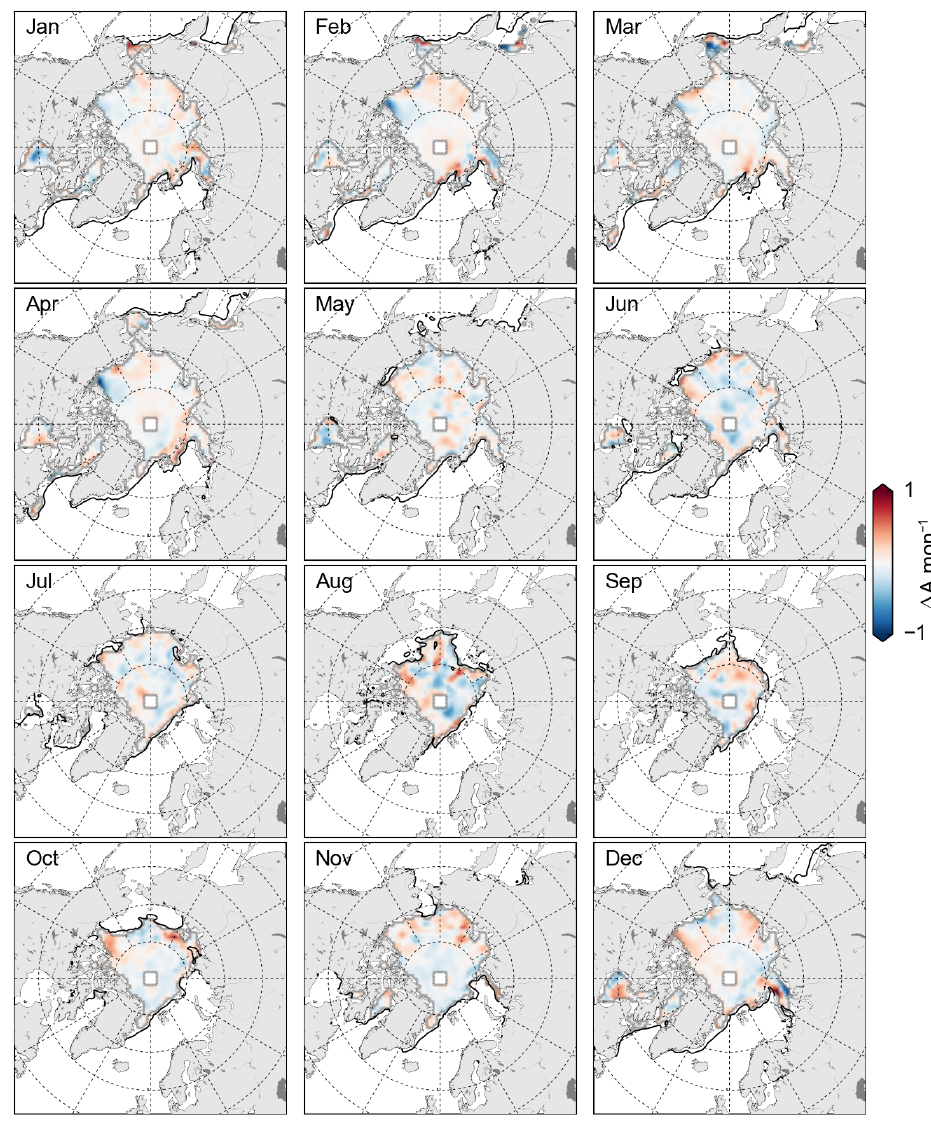
Figure 7. Monthly 2016 flux divergence anomalies, relative to the 2003–2015 mean, calculated using the daily Bootstrap sea ice concentration data and KIMURA drift data. Positive values (red) denote more ice gain in a given grid cell compared to the mean. The units are concentration per month. The black contour indicates the monthly 2016 sea ice edge (0.15 ice concentration